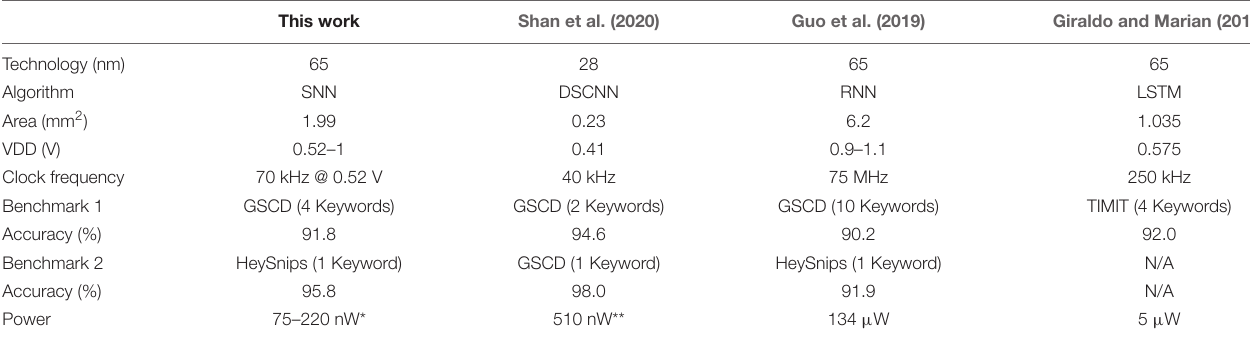
TABLE 1 | Comparisons with recent KWS hardware.